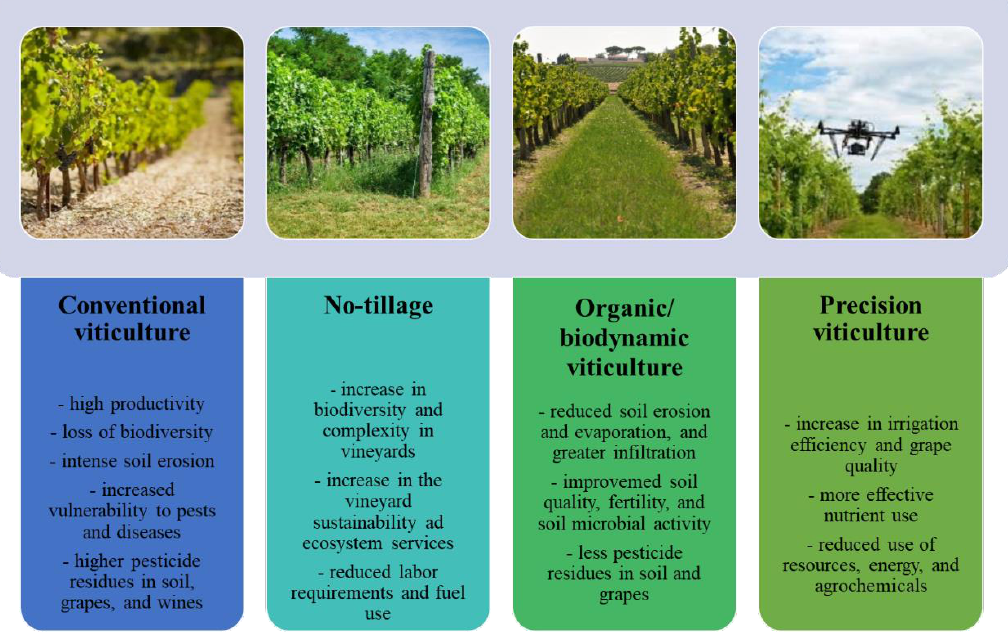
Figure 3. Sustainability of viticulture practices.